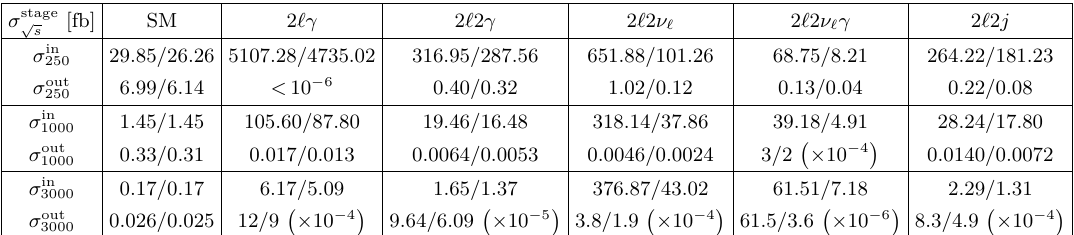
JHEP02(2022)176